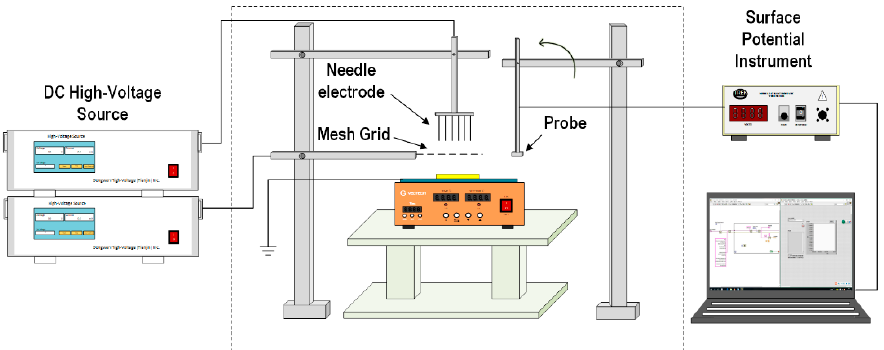
Figure 3. Isothermal surface potential decay measurement system.